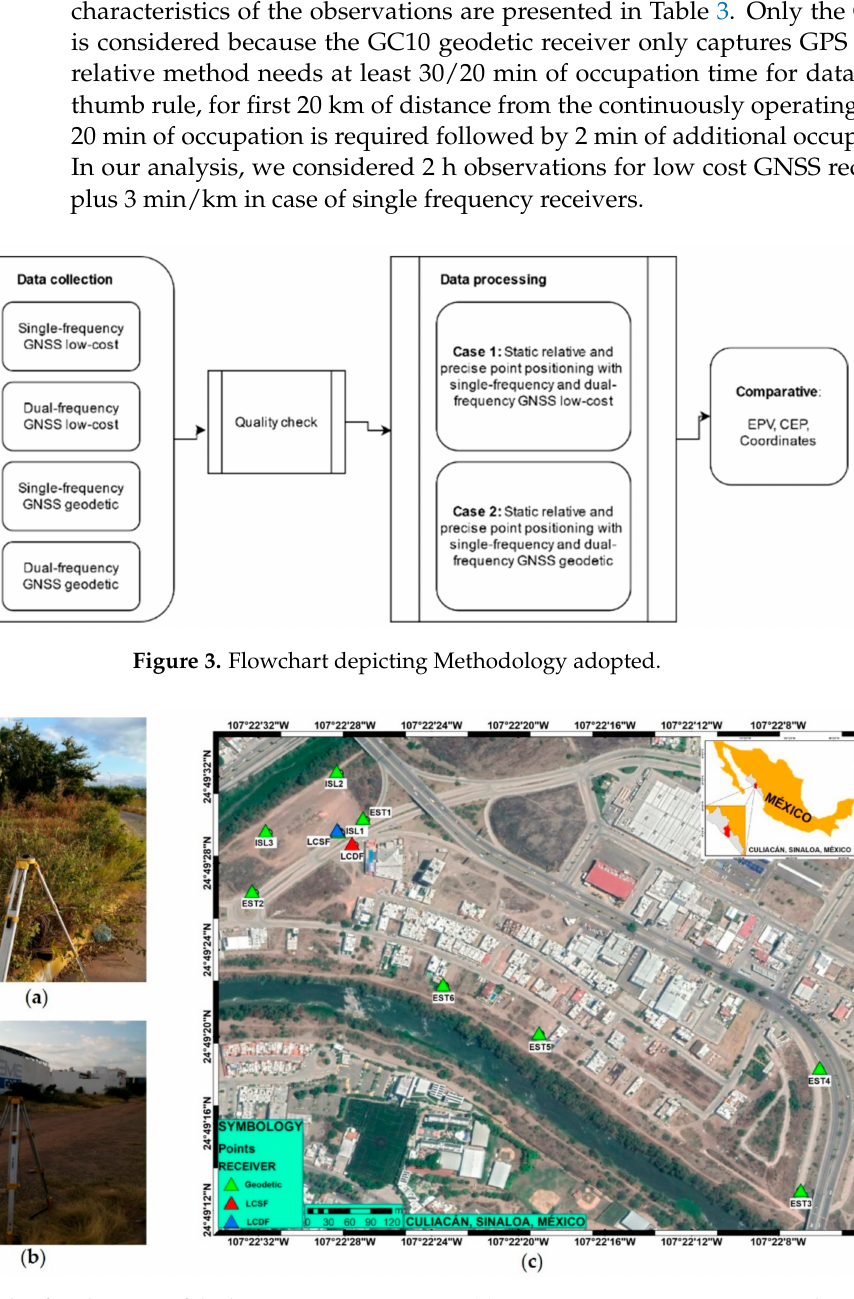
Figure 4. ( a , b ) Example of 3D location of the low cost GNSS Antenna. ( c ) Location GNSS stations occupied in the observation campaigns, located in Culiac á n Sinaloa,